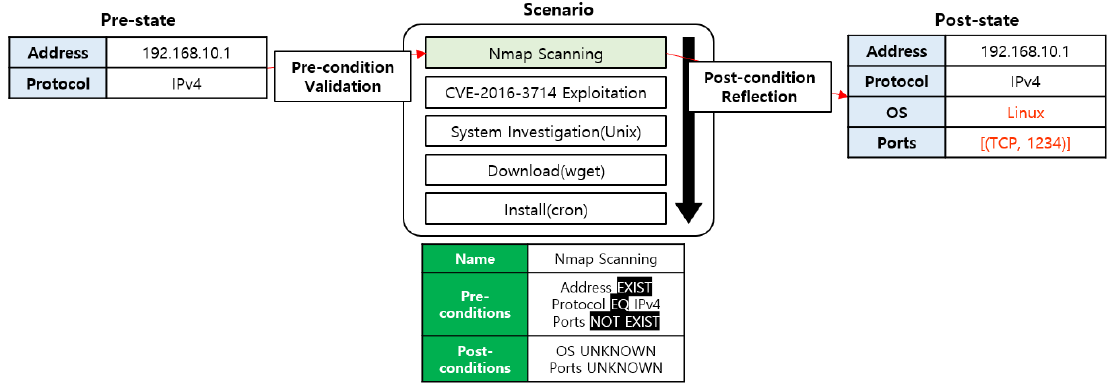
Figure 8. The example of the process of scenario performance: port scanning.